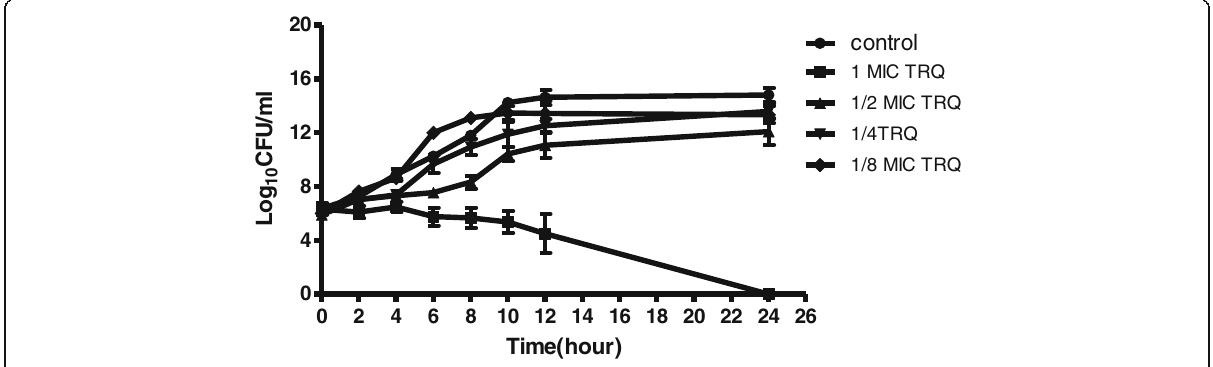
Fig. 1 Activity of TRQ at different concentrations in a time-kill analysis against MRSA